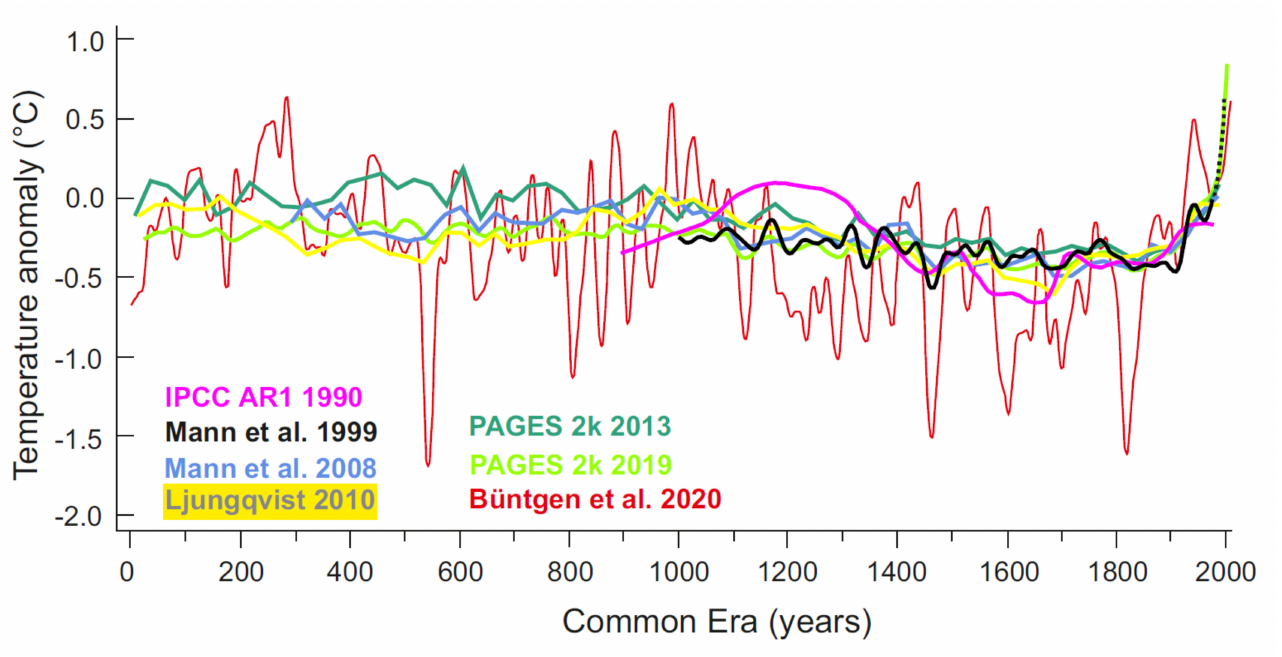
Figure 1. Comparison of the seven T2k composites. Anomaly refers to 1961–1990 temperature average. Smoothing filters: 40 years for MM99 and MM08, 30 years for LJU10, PA13, PA19, and